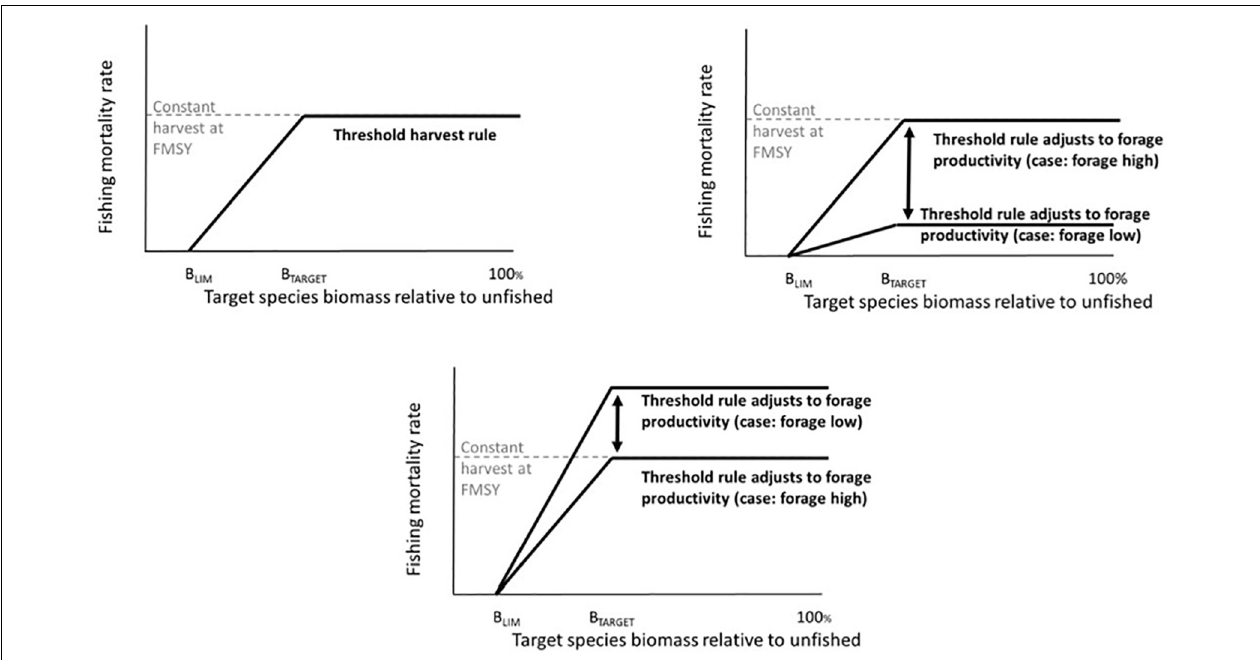
FIGURE 2 | Top left panel : Threshold harvest control rule and constant fishing mortality rate at FMSY. Top right panel : Threshold harvest control rule that decreases F when the forage base declines. Bottom panel : Threshold harvest control rule that increases F when the forage base declines.